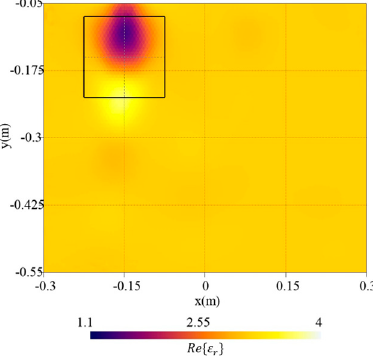
Figure 6. Reconstructed distribution of the real part of the dielectric permittivity, Re { ε r } , in the investigation domain R together with a square box indicating the shape of the actual target. Reference case.